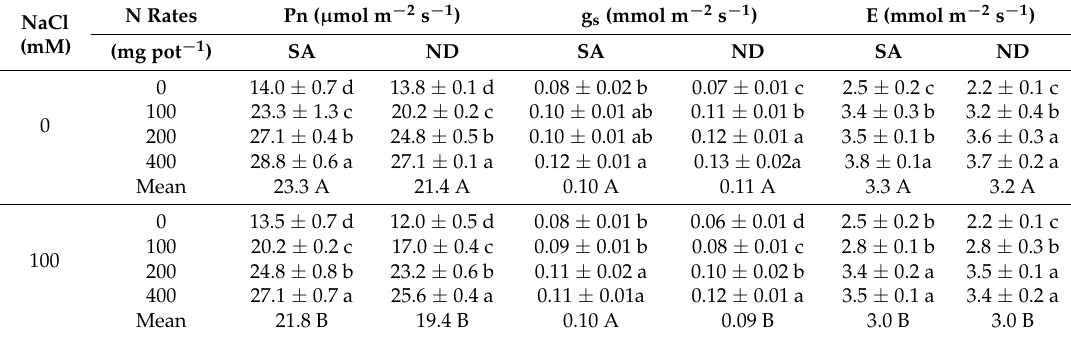
Table 4. Effects of salinity and nitrogen rate on the photosynthetic rate (Pn), stomatal conductance (g s ), and transpiration rate (E) of the two oat genotypes (SA vs. ND) at the flowering stage in the second run of a controlled greenhouse